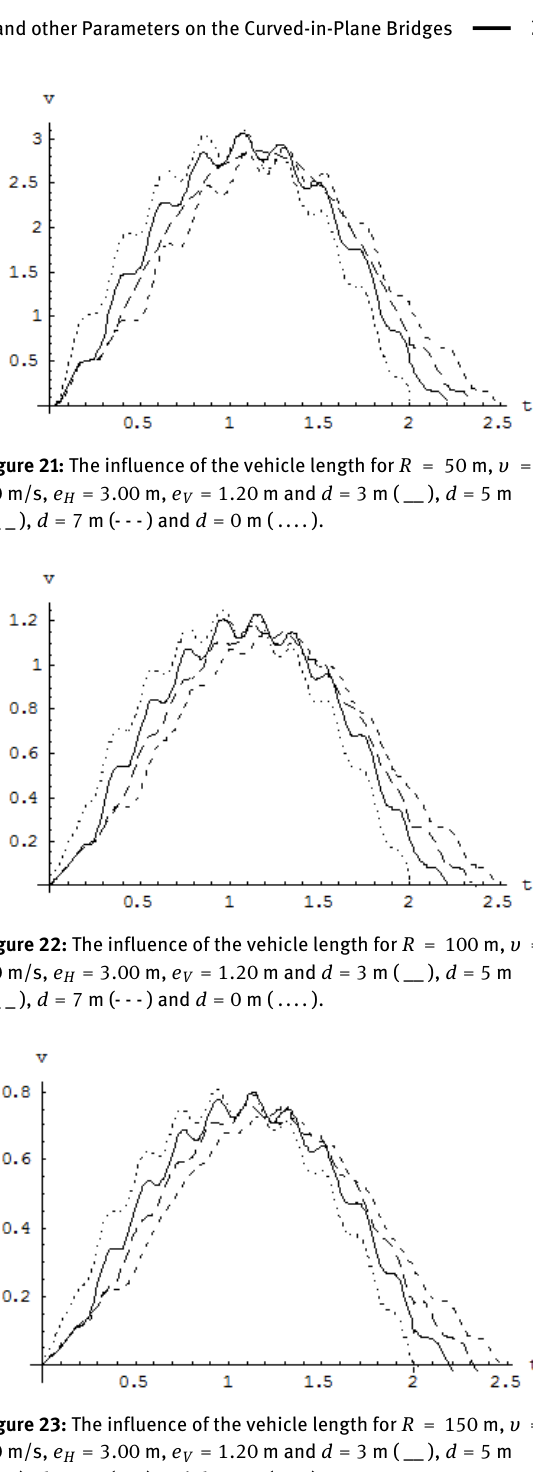
The plots of Fig. 25 show the vertical-torsional motion of the middle of the bridge (at x = L /2), for R = 100 m, υ = 30 m/s, e H = 3.00 m, e V = 1.20 m and the same as above three models of loading. The plots of Fig. 26 show the vertical-torsional motion of the middle of the bridge (at x = L /2), for R = 100